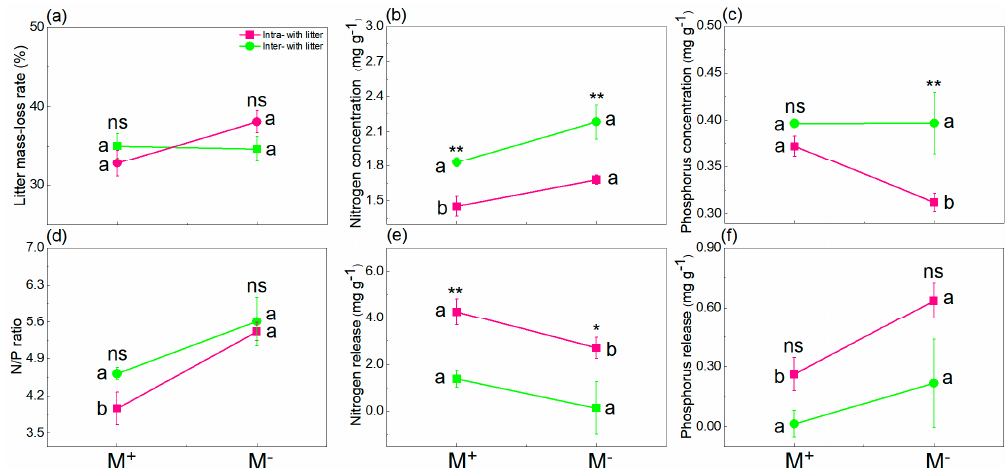
Abbreviations: M = AM fungus treatments; C = Competition pattern treatments. p < 0.05 and p < 0.01 indicate significant differences, and p < 0.001 indicates highly significant differences.